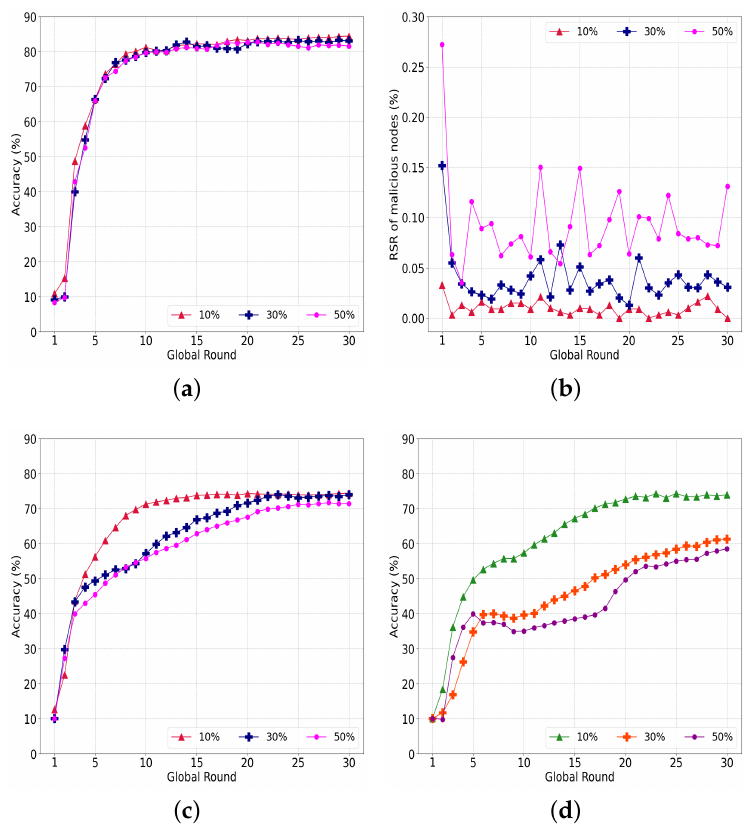
Figure 11. Evaluation of our system under data-poisoning attacks. ( a ) Performance of the proposed system; ( b ) RSR with varying ratio of attackers; ( c ) Performance of legacy FedAvg ; ( d ) Performance of less-trained FedAvg